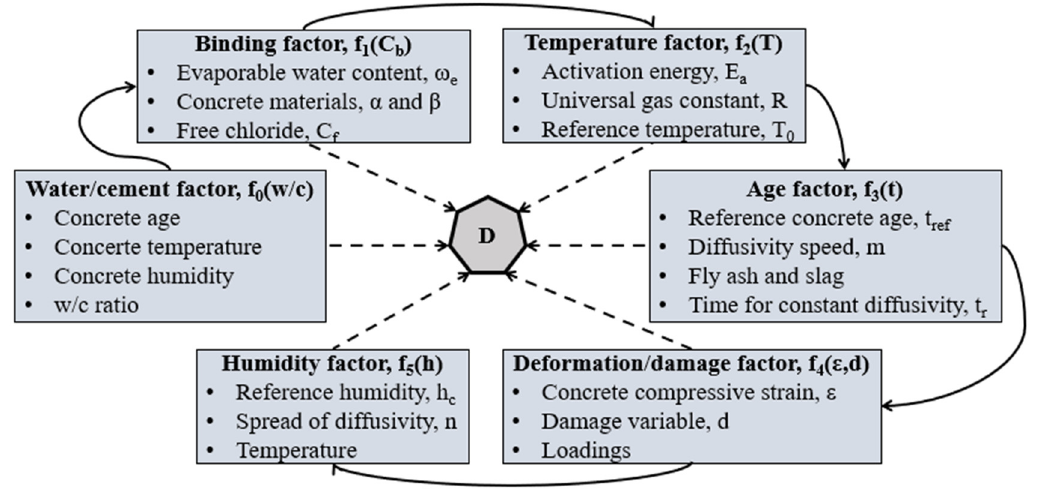
Figure 2. Representation of used 6 factors (from f 0 to f 5 ) and 20 sub-factors correlated to the chloride diffusion coefficient D.